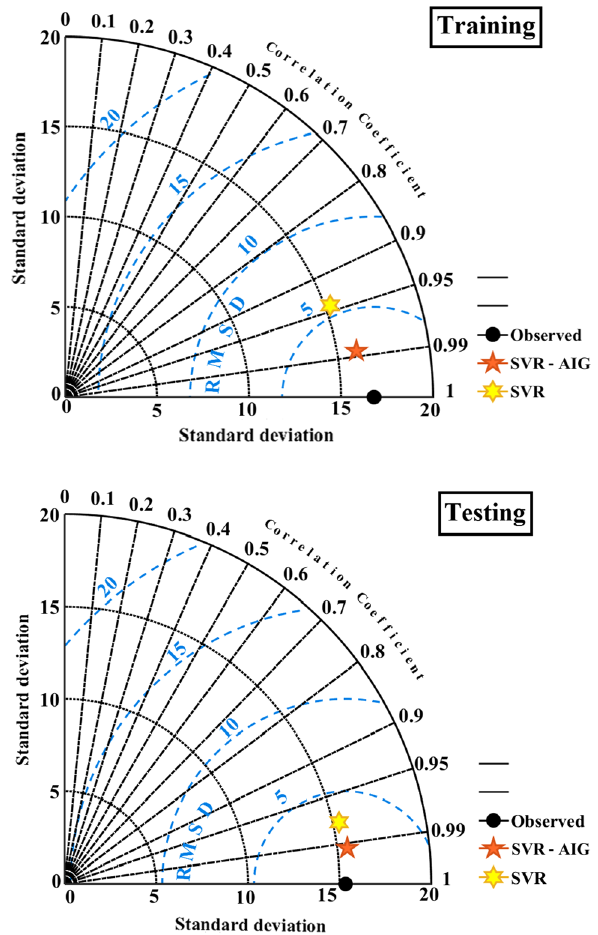
Fig. 6 Taylor diagrams of the models at the training and testing peri-